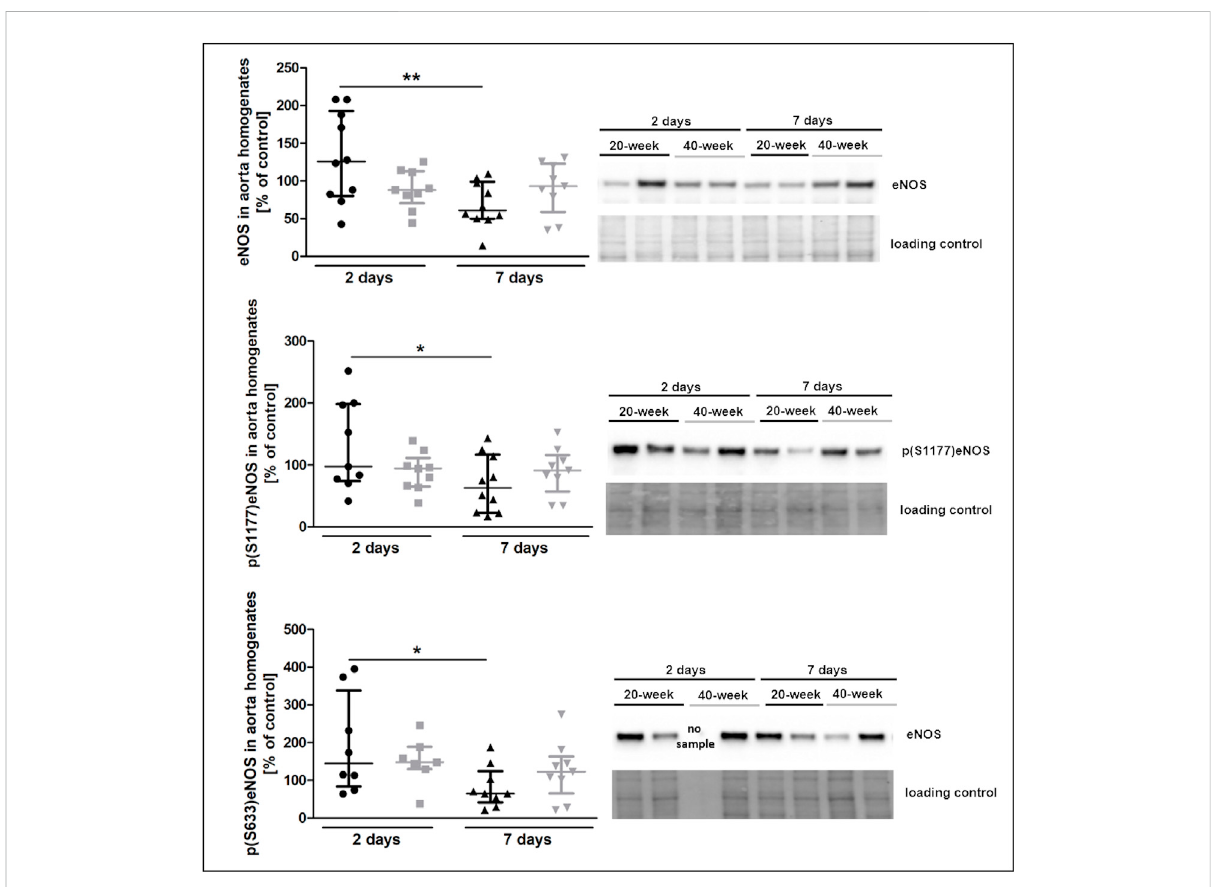
FIGURE 5 eNOS level and phosphorylation at Ser1177 and Ser633 in the aorta of 4T1 breast cancer cell-injected 20-week-old and 40-week-old BALB/c mice. Black symbols denote 20-week-old mice, and grey symbols denote 40-week-old mice. eNOS level and its absolute phosphorylation at S1177 and S633 in the aorta of 20-week-old and 40-week-old mice two and 7 days post-injection of 4T1 breast cancer cells are shown by representativewesternblots( n =7 – 10).ThedataareshownasthemedianandIQRandwerecomparedwithparametrictwo-wayANOVA.Key: * p < 0.05; ** p <